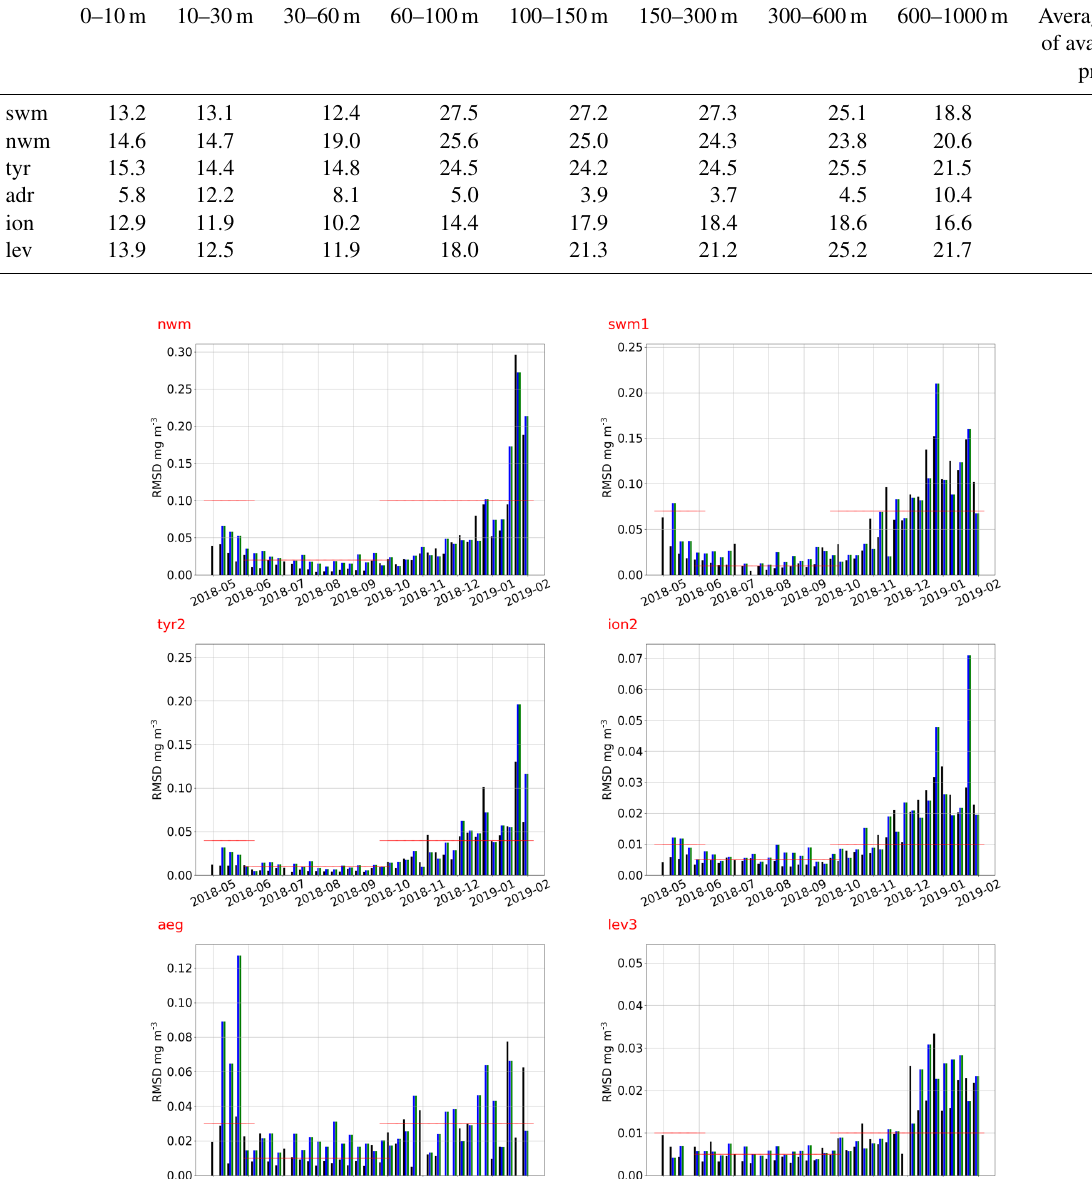
Figure 12. Sub-basin RMSD between surface chlorophyll model forecast at lead time 24 ( T 1, black), 48 ( T 2, blue), and 72h ( T 3, green) and daily satellite maps. As benchmark reference, the two seasonal mean RMSD values computed from the qualification run are shown (red